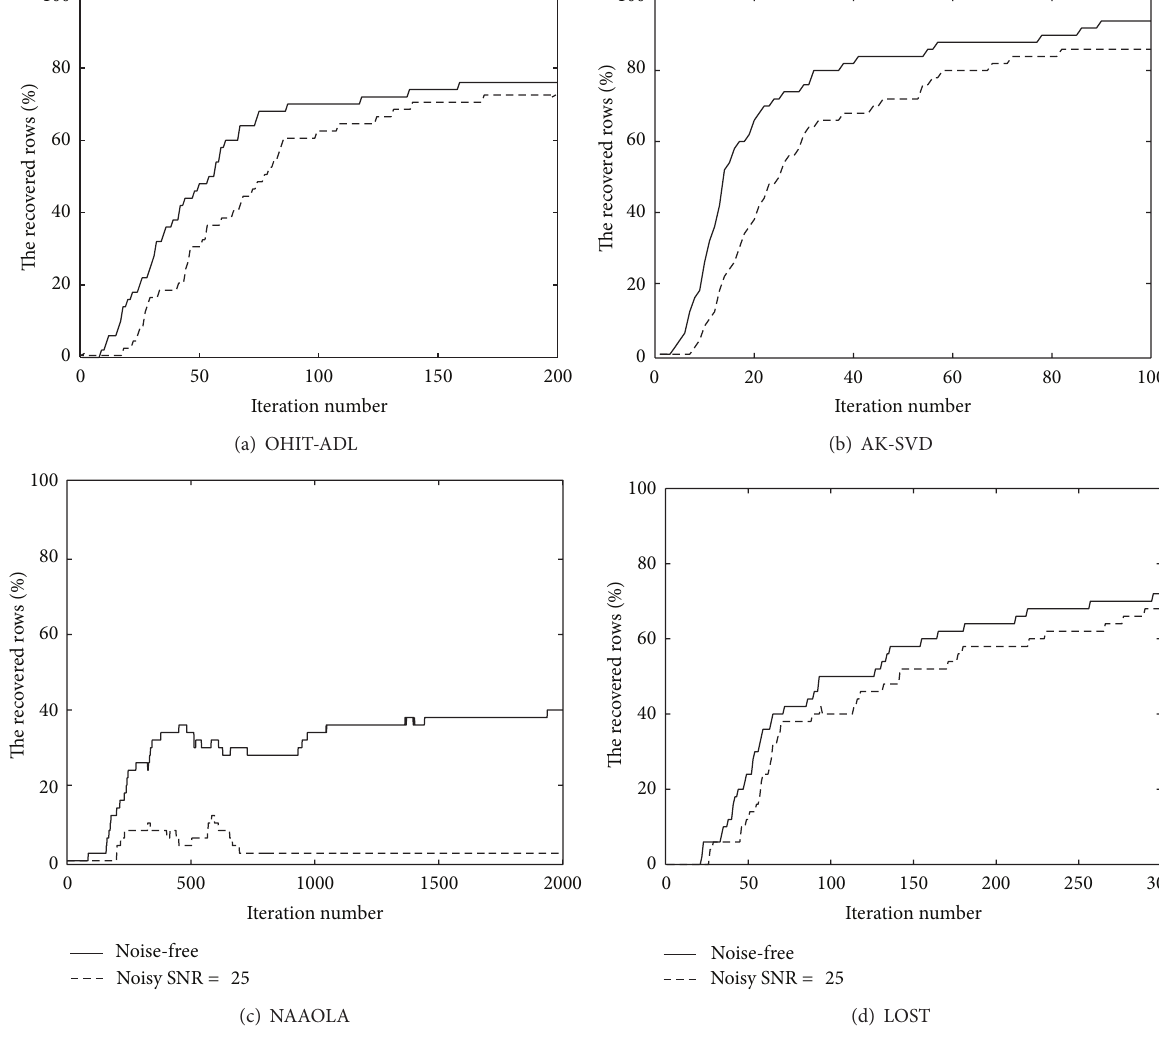
Figure 2: The recovery percentage curves of the ADL